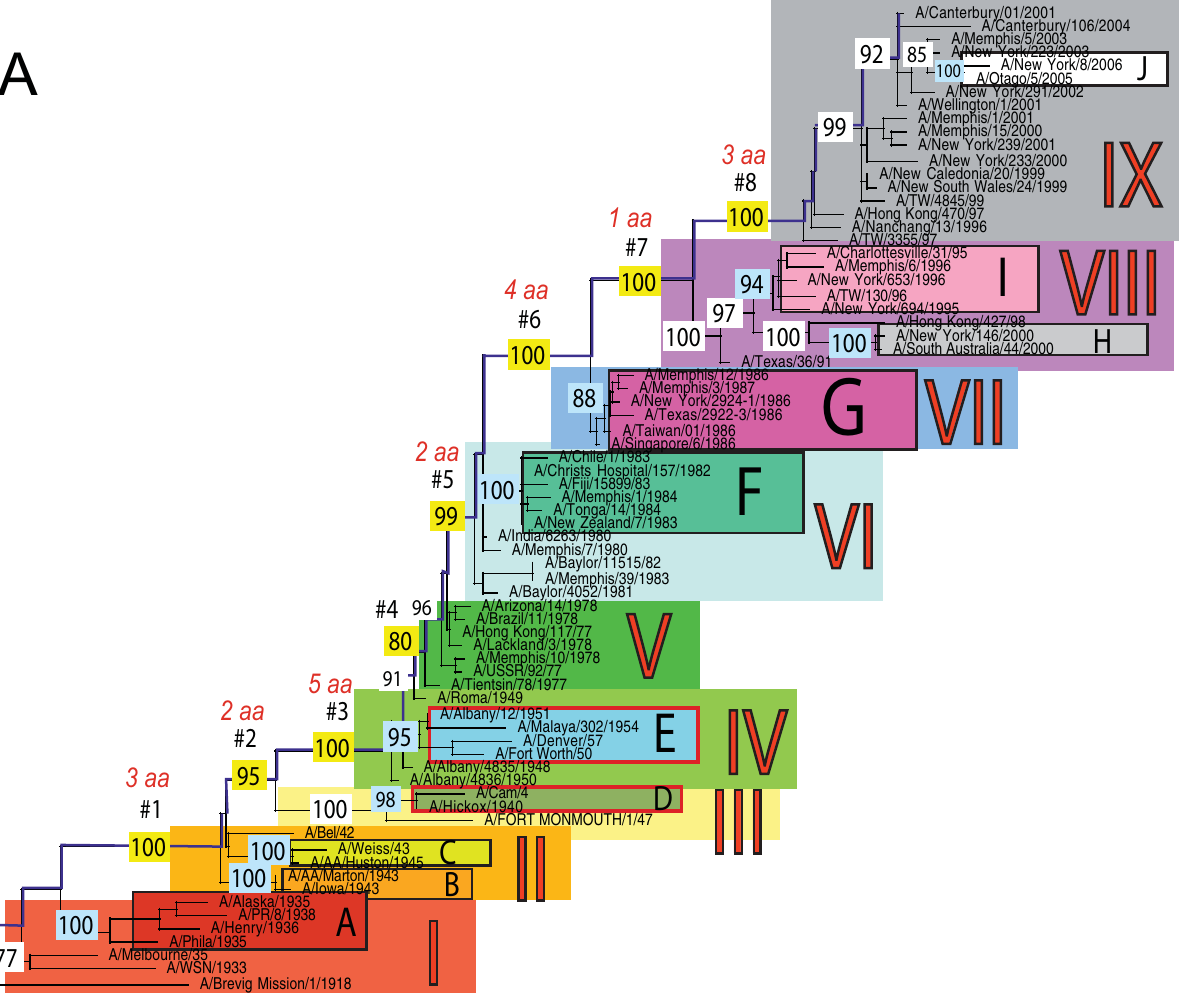
Figure 3. Phylogenetic relationships of the PA gene of A/H1N1 influenza viruses (n=71) sampled globally from 1918–2006, estimated using ML. Rooting, scale, and color scheme are the same as those used in Figure 1.